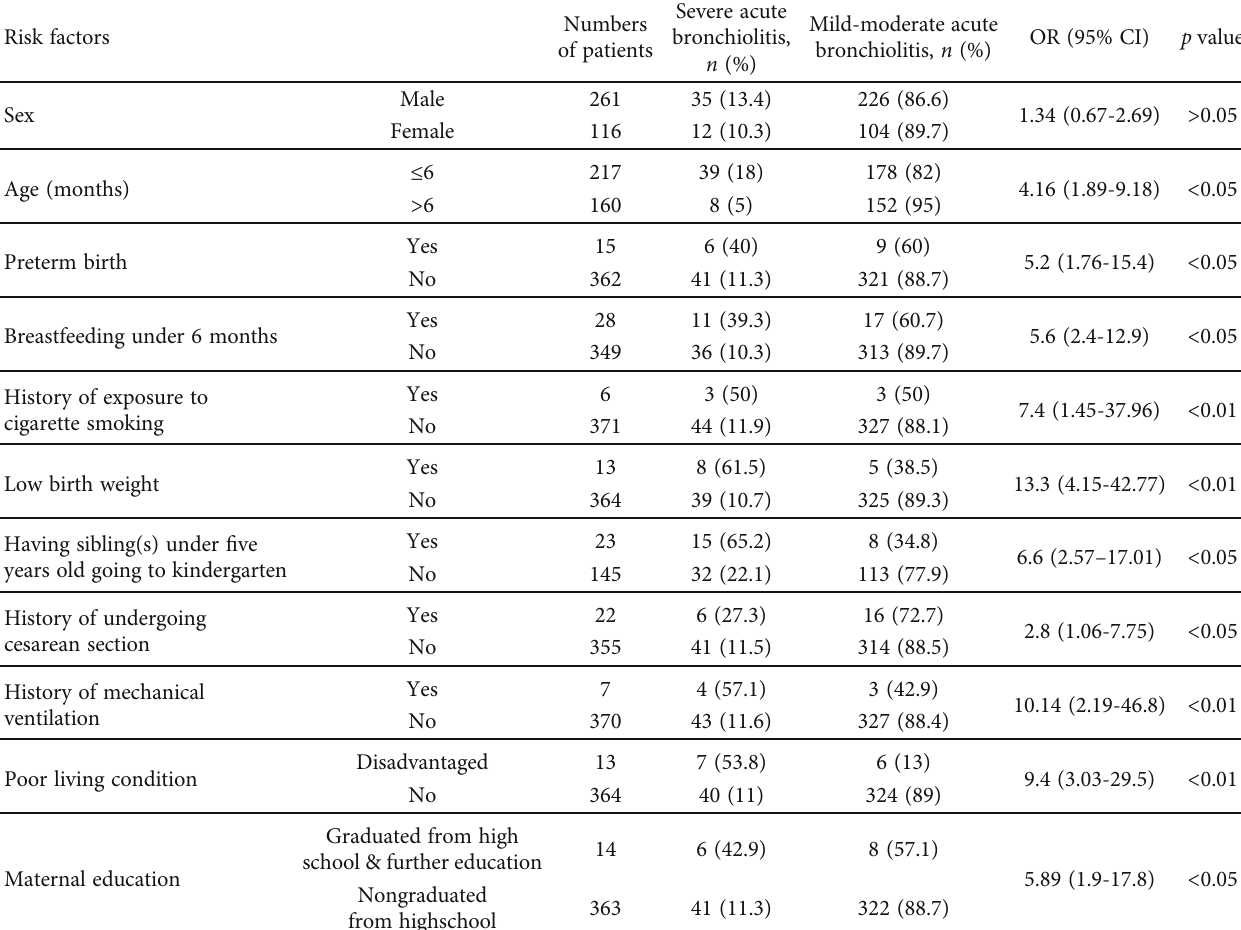
Table 7: The risk factors of severe acute bronchiolitis caused by RSV ( n = 377